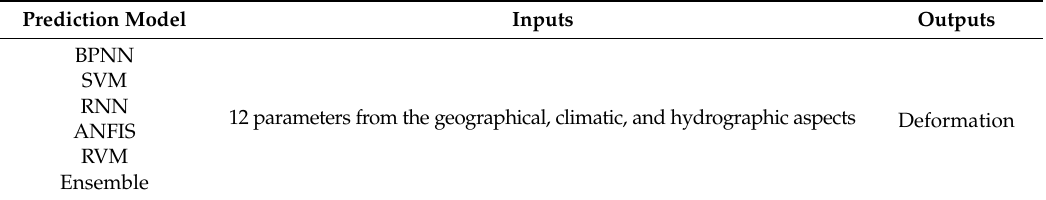
Table 2. Inputs and output of the prediction models.